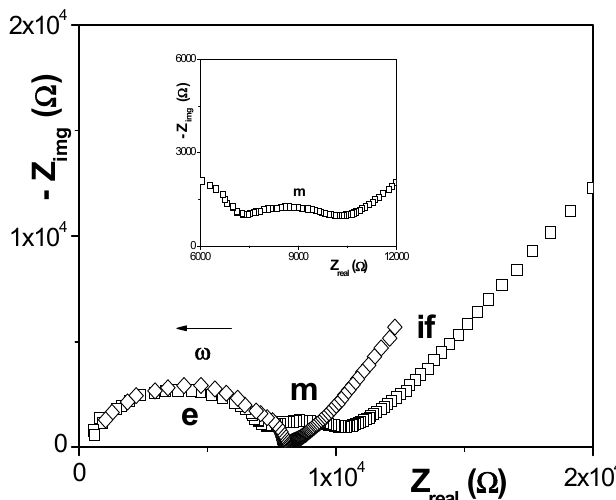
Figure 5. Nyquist plots for ( □ ) Sf-NPAM/TiO 2 membrane and ( ◊ ) Ox-NPAM/TiO 2 membrane. (e) Electrolyte solution; (m) membrane; (if) interface; ω : angular frequency and values increase ten- dency.